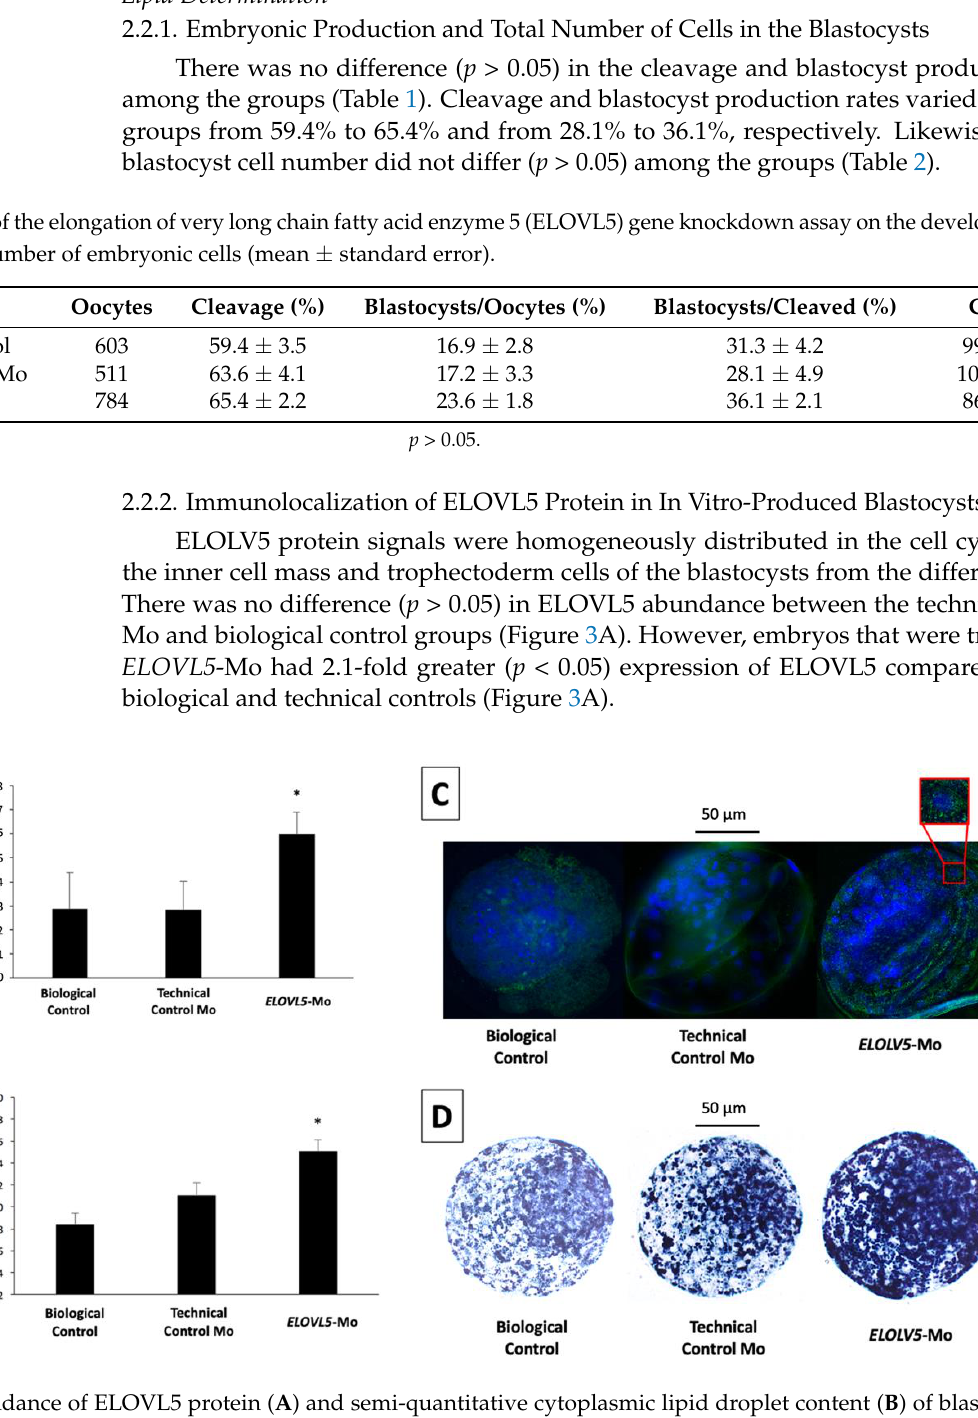
Figure 3. Abundance of ELOVL5 protein ( A ) and semi-quantitative cytoplasmic lipid droplet content ( B ) of blastocysts produced in vitro from the biological control, technical control Mo, and ELOVL5 -Mo groups. Representative immunofluorescence images of in vitro-produced blastocysts from the biological control, the technical control, and ELOVL5 -Mo groups; in detail, the distribution of ELOVL5 protein; nuclear DNA is stained with Hoescht 33342 (blue) and ELOVL5 protein is stained with fluorescein isothiocyanate (FITC, green) ( C ). Representative images of the cytoplasmic lipid droplet deposition of in vitro-produced blastocysts from the biological control, technical control, and ELOVL5 -Mo groups; black areas indicate sudanophilic cytoplasmic lipid droplets ( D ). * p < 0.05.